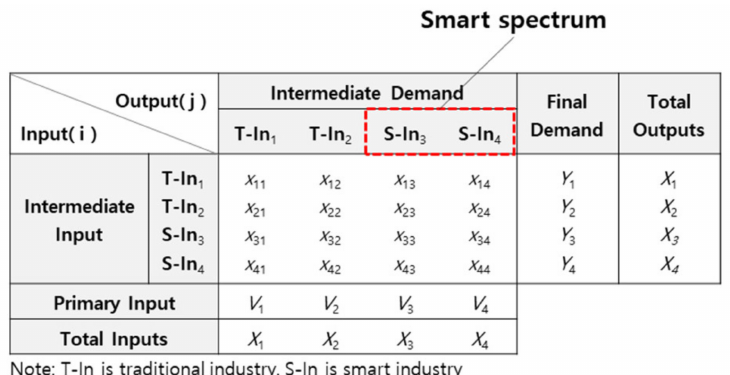
Figure 3. Example of the calculation of the smart spectrum.